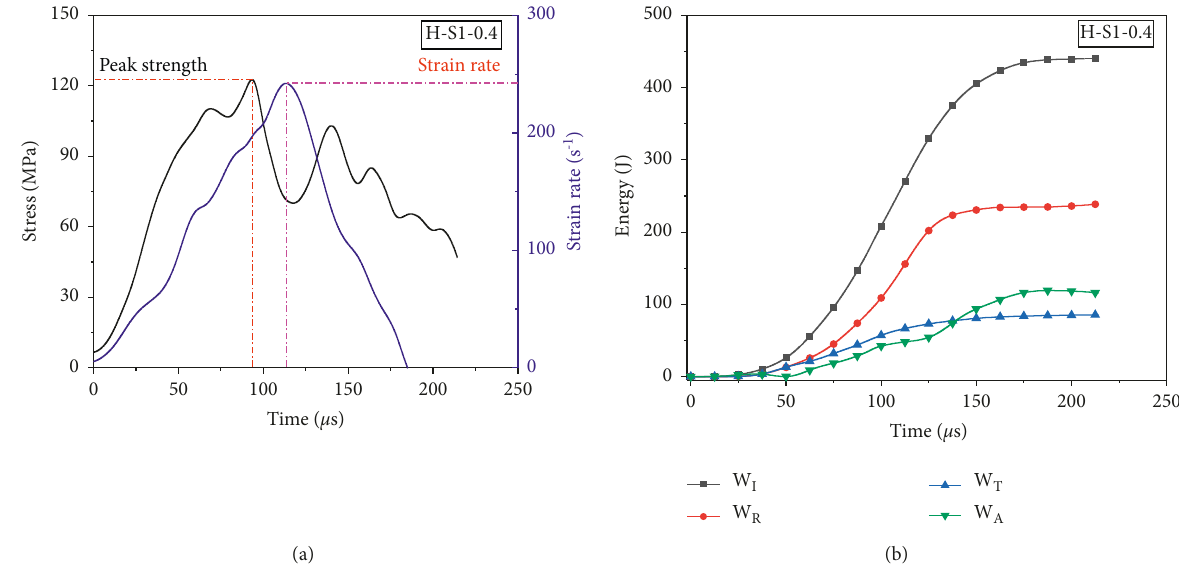
Figure 5: (a) Determination of peak stress and strain rate, and (b) energy evolution of specimen